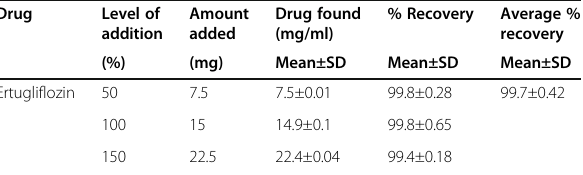
Table 4 Intra-day and inter-day precision of ertugliflozin ( n =6) Drug Concentration Intra-day precision